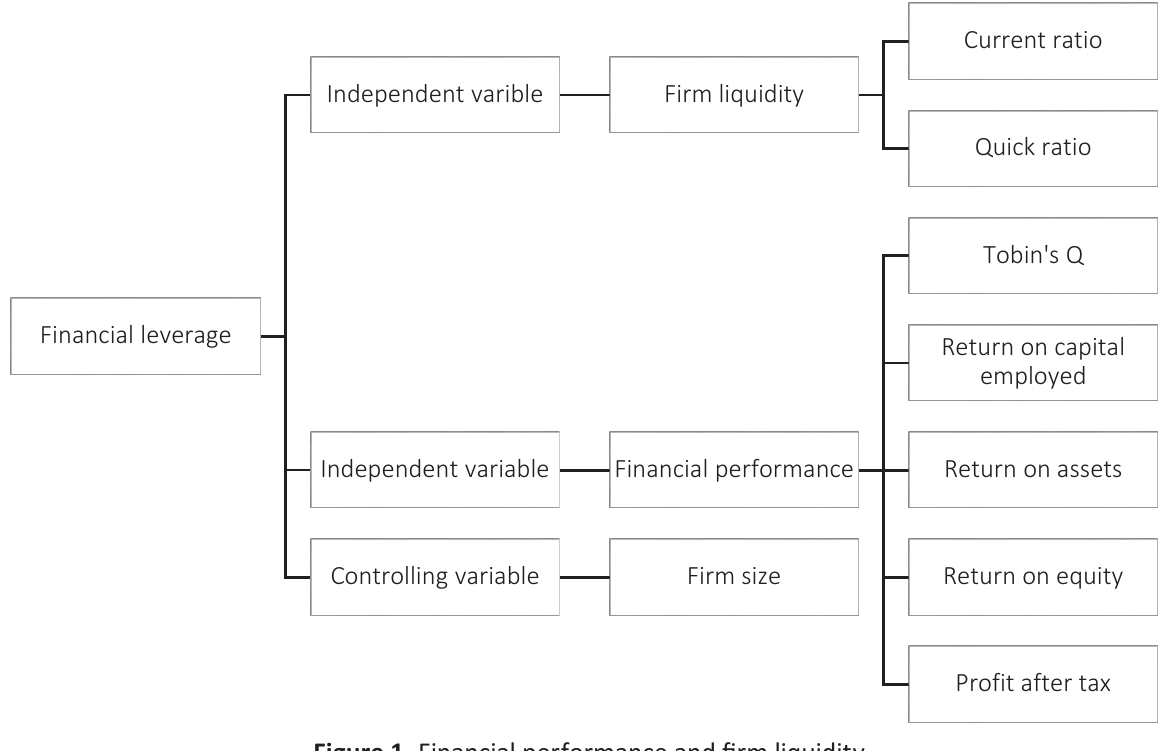
Figure 1. Financial performance and firm